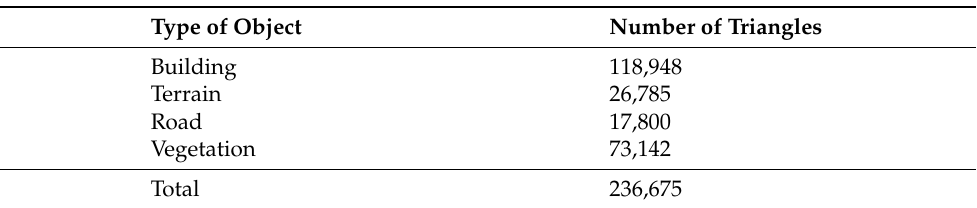
Table 1. Different types of objects shown in Figure 6 and the associated number of triangles for a 1 × 1 km tile of Lyon.